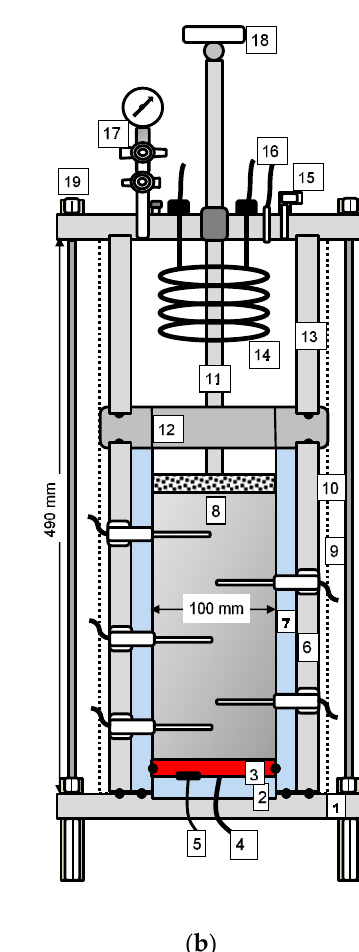
Figure 1. Schematics of the thermo-hydraulic column cells used in this study: ( a ) device A, for tests at 85 °C; ( b ) device B, for tests at 150 °C.